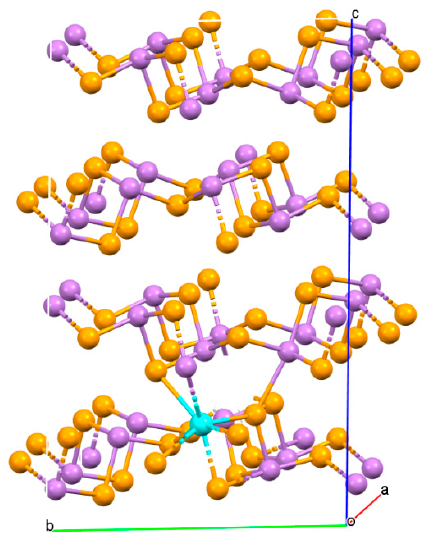
Figure 7. Crystal structure of Y doped As 2 Se 3 along the crystal axes, as is shown in violet; Se in orange and Y in cyan.